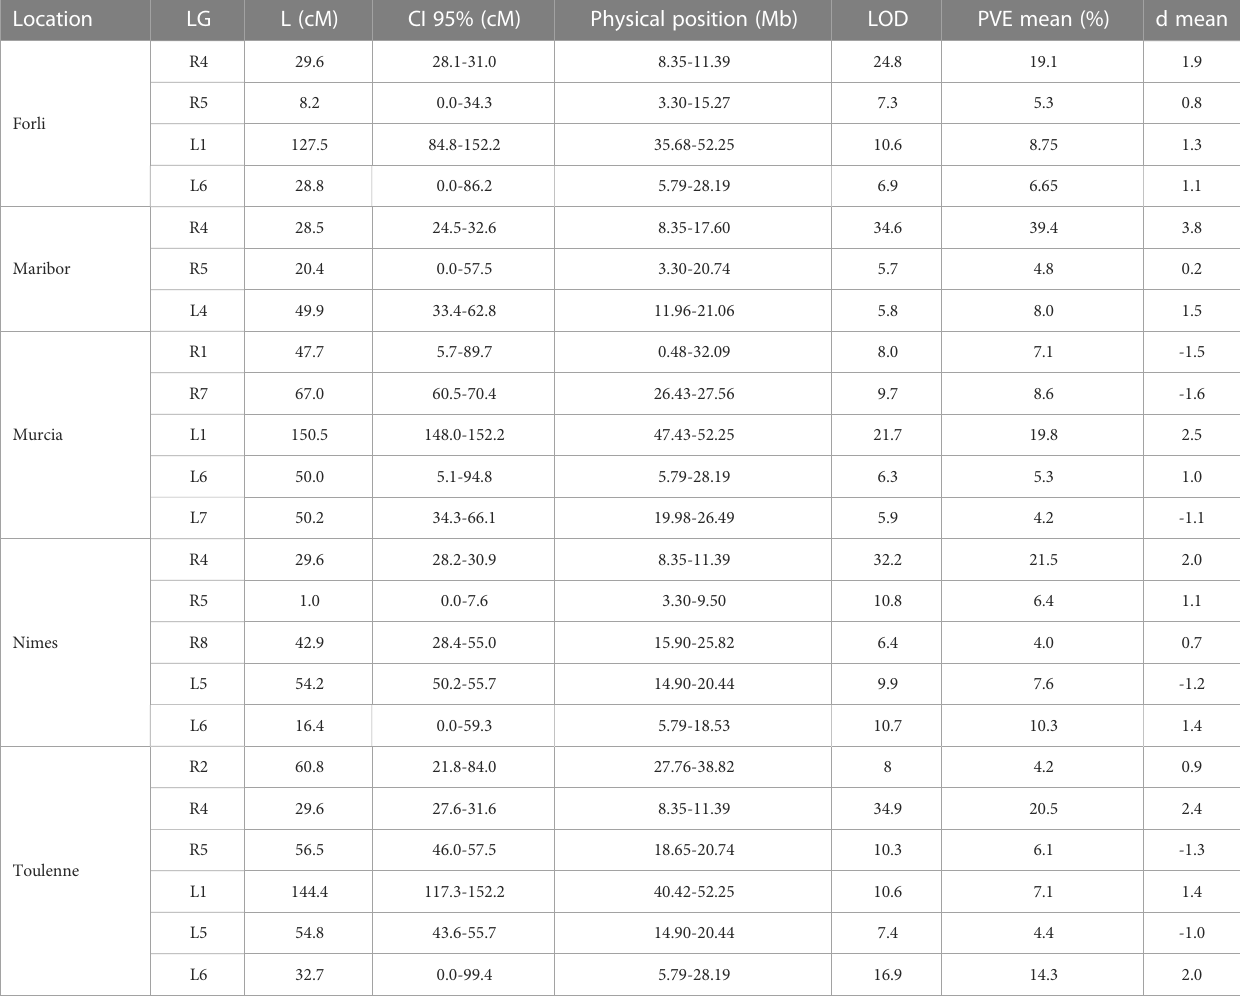
TABLE 1 Beginning of fl owering (BF) QTLs detected with the multi-year analysis in each location. Location LG L (cM) CI 95% (cM) Physical position (Mb) LOD